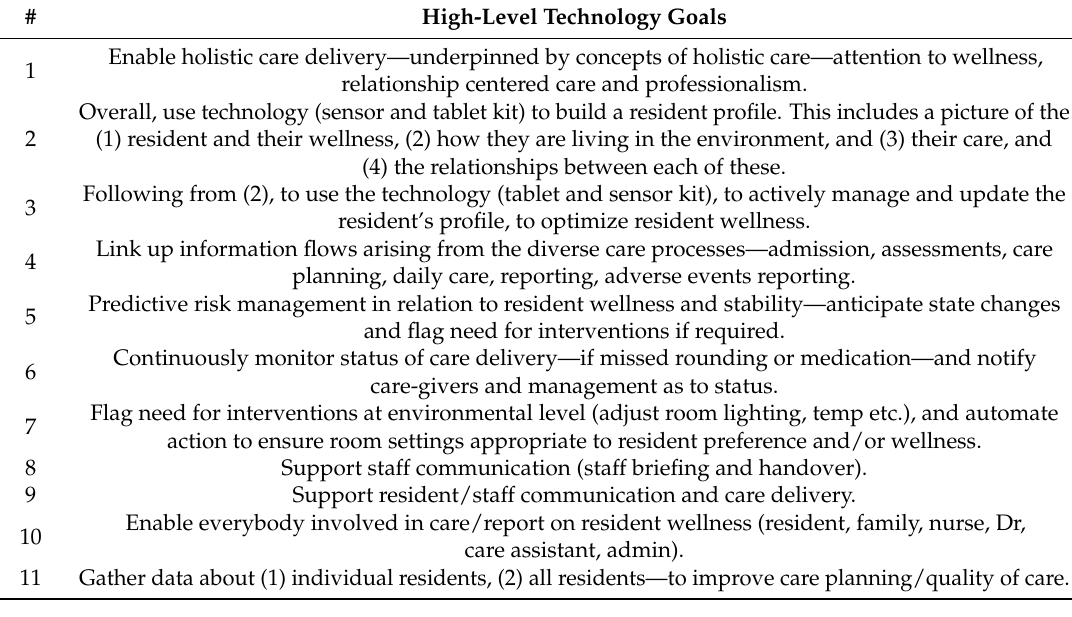
Table 2. High-level technology